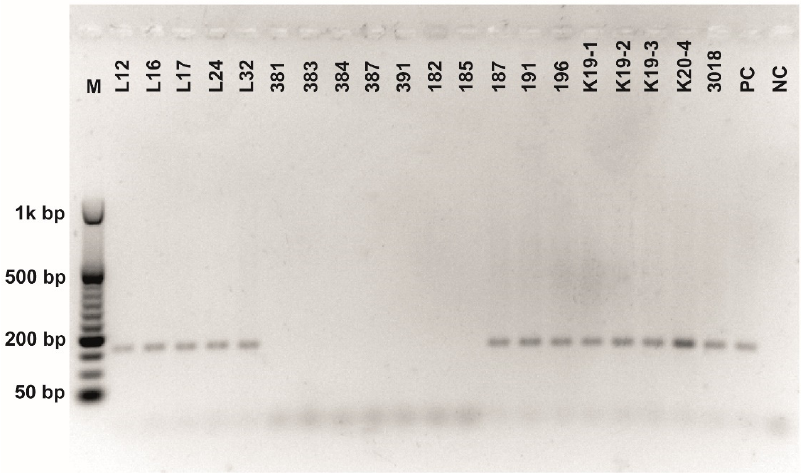
Fermentation 2022 , 7 , x FOR PEER REVIEW 27 of 31 Figure A4. Class 2a bacteriocin gene belonging to the Clade 2 amplification. O’RangeRuler TM 50 bp DNA Ladder was used as a molecular marker. PC-positive control by strain ATTCC 14917.